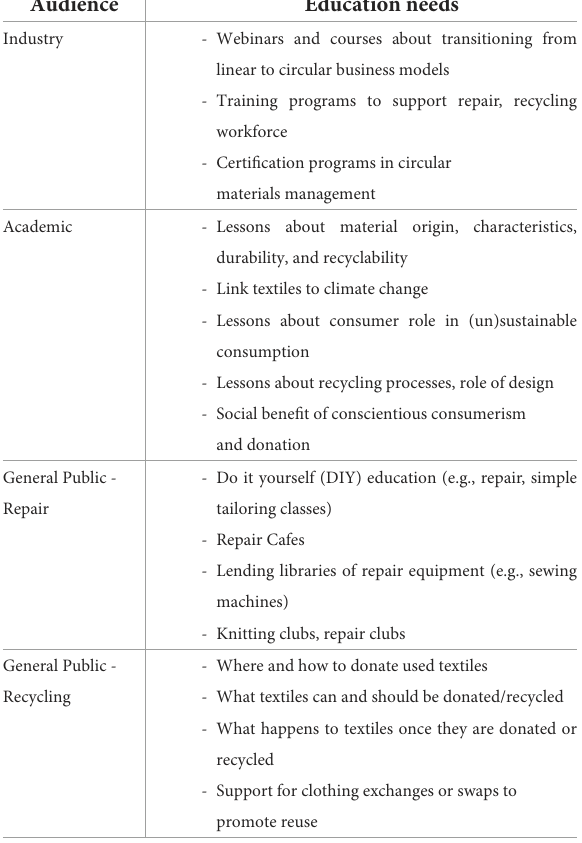
TABLE 9 Engagement and education approaches to support textiles circularity.